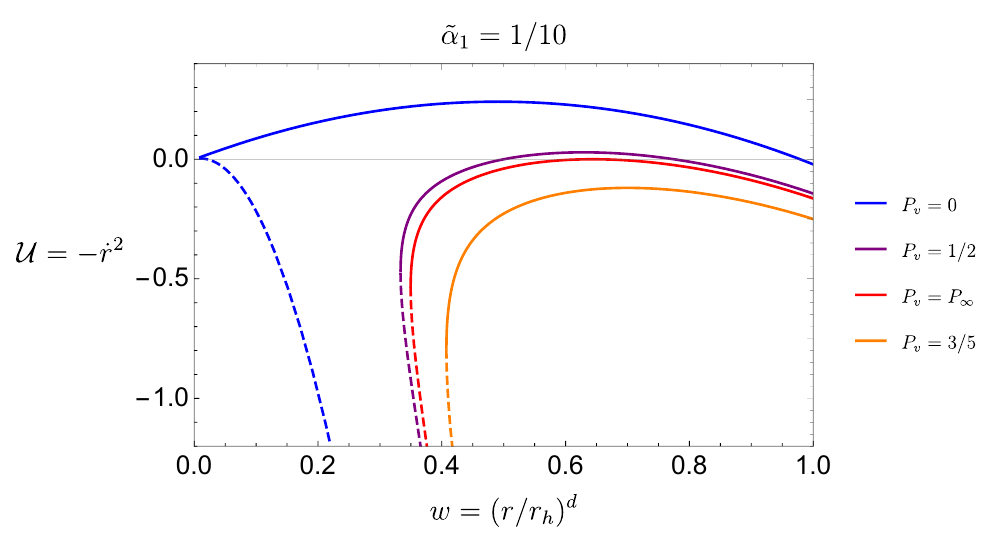
Figure 9 . The effective potentials U ( P v , r ) defined in eq. (B.11) (for a planar black hole solution) with various fixed conserved momentum P branch derived in eq. (B.11), respectively. We have fixed r